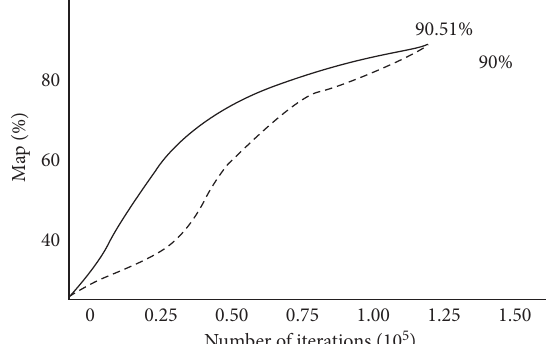
Figure 4: Comparison of total loss and accuracy of migration training and random initialization (varies with the number of